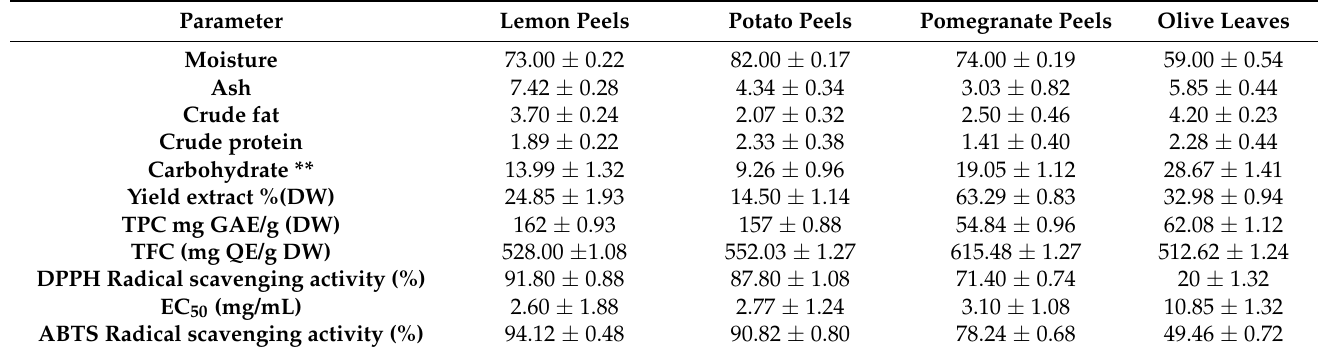
Table 1. Proximate analysis *, yield extract, TPC, TFC, and antioxidant scavenging activity of lemon peels, potato peels, olive leaves, and pomegranate peels